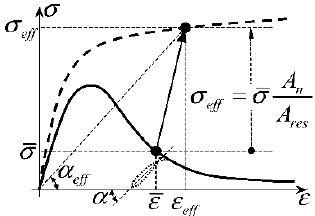
Figure 13. Identification of the effective properties starting from the average properties.